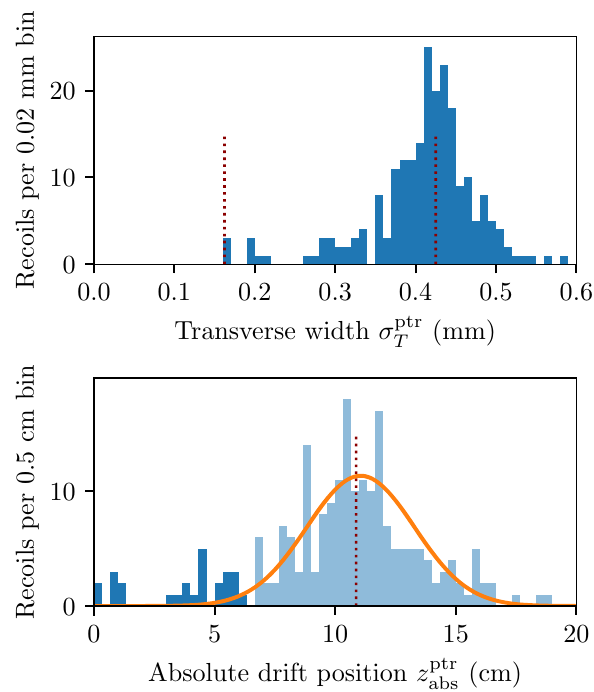
Fig. 16 Histograms of the transverse width σ T (top) and derived abso- lute position z abs (bottom) for neutron candidates from the beam-off dataset. The expected left and right edge of the σ T plateau from the beam-on calibration of Sect. 7.2 and the position of the cathode in z are shown with dotted vertical lines. We fit the z abs distribution with a Gaussian (orange line) to define a 2 σ exclusion region (light blue range). The remaining tracks (dark blue) are considered to be inside the fiducial volume of the TPC